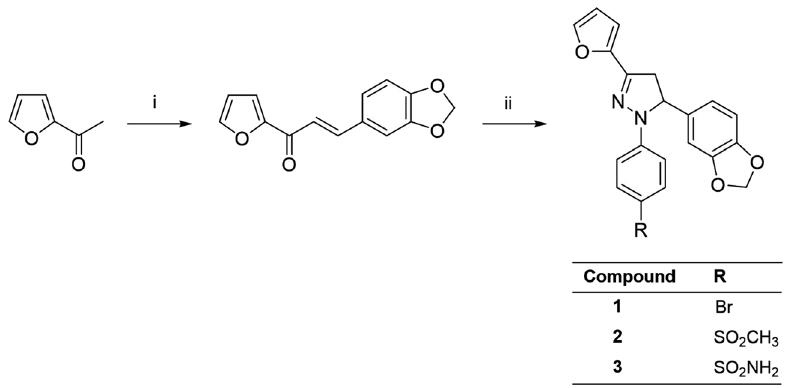
Figure 1: The synthetic route for the preparation of compounds 1 – 3. Reagents and conditions: (i) Piperonal, 10% (w/v) NaOH, absolute ethanol, rt, 24 h; (ii) 4-substituted phenylhydrazine hydrochloride, AcOH, absolute ethanol, re fl ux, 10